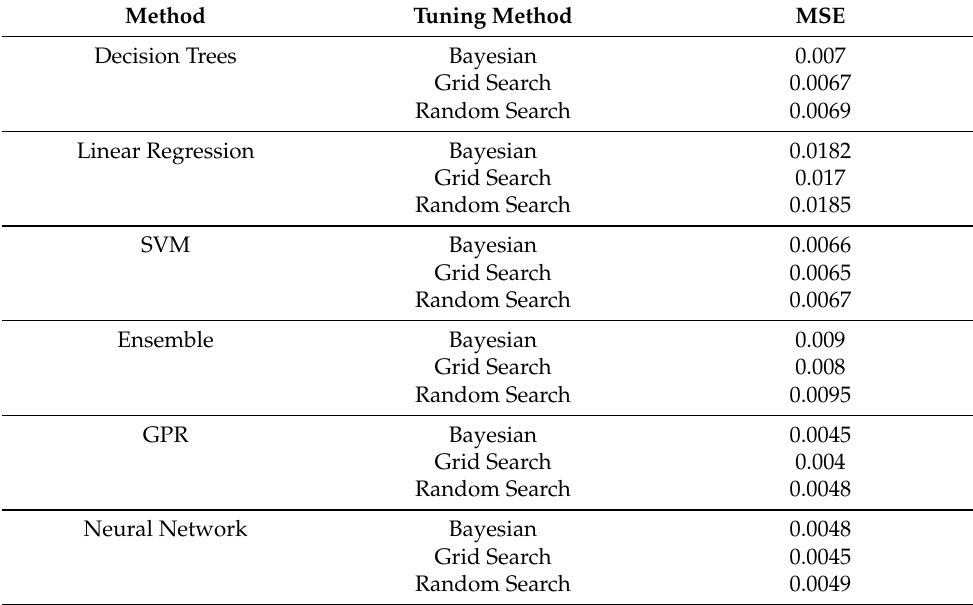
Table A1. Results of Hyperparameter tuning for methods used in the